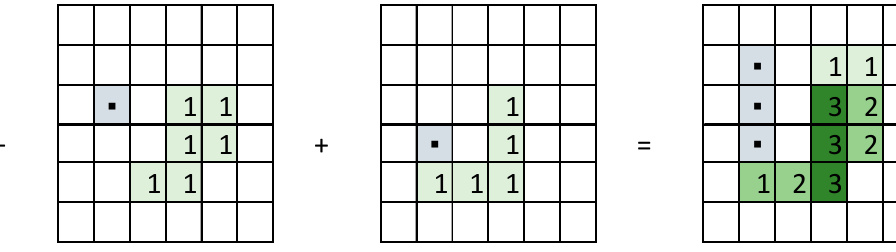
Figure 3. Cumulative viewshed method: numbers in the cell indicates the number of times each cell is visible from the three points in the grey cells.